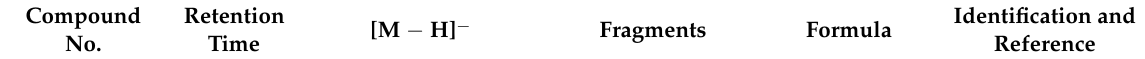
Figure 3. Diffusion order spectroscopy (DOSY) spectrum showing some of the different classes of constituents present in the C. hirtus extract.